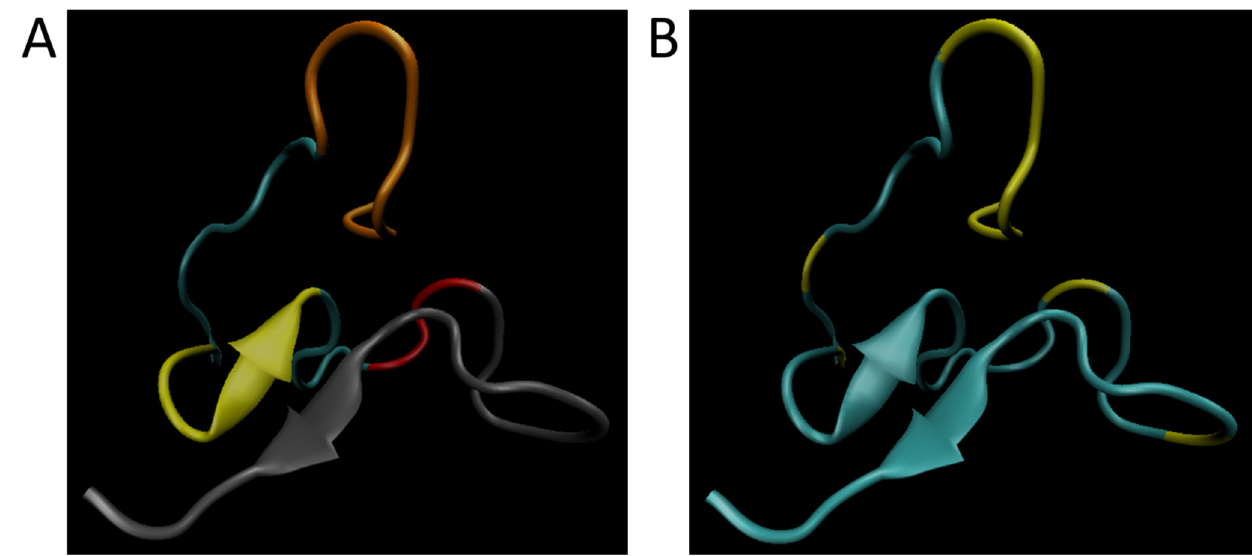
Figure 2. Image of residues on A β . ( A ) Simulated wild-type structure of A β showing the signaling domain in the N- terminus (Residues 1–8, orange), the hydrophobic cluster (Residues 17–21; yellow), the hairpin turn region (Residues 27–29; red), and the oligomerization domain in the C-terminus (Residues 30–42; gray). ( B ) Simulated wild-type structure showing the significant residues (Residues are 2–7, 13, 16, 29, and 33) predicted by this research have been highlighted in yellow.